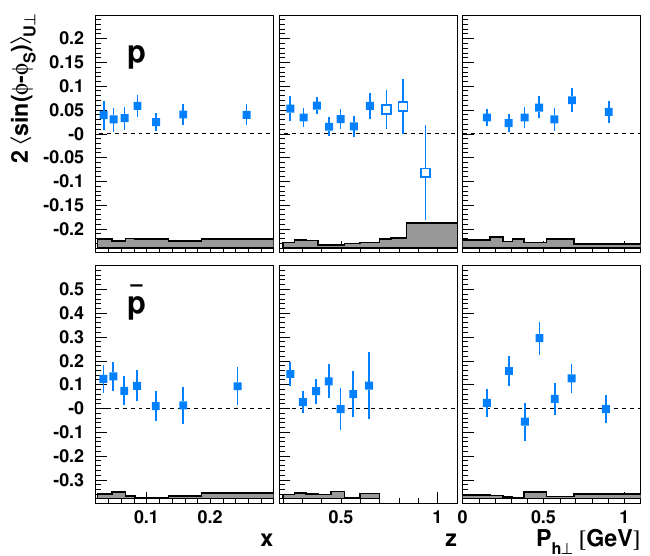
Figure 16 . Sivers SFA for protons (upper row) and antiprotons (lower row) presented either in bins of x , z , or P h ⊥ . Data at large values of z , marked by open points in the z projection, are not included in the other projections (no such high- z points are available for antiprotons due to a lack of precision). Systematic uncertainties are given as bands, not including the additional scale uncertainty of 7.3% due to the precision of the target-polarization determination.